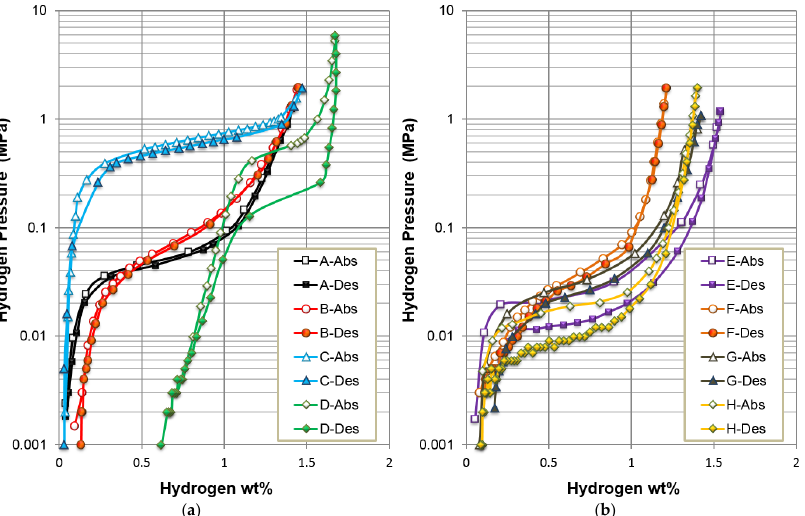
Figure 1. Pressure-concentration-temperature system (PCT) isotherms measured at 30 ◦ C for as-is alloys ( a ) A – D and ( b ) E – H . Open and solid symbols represent the absorption and desorption curves, respectively.